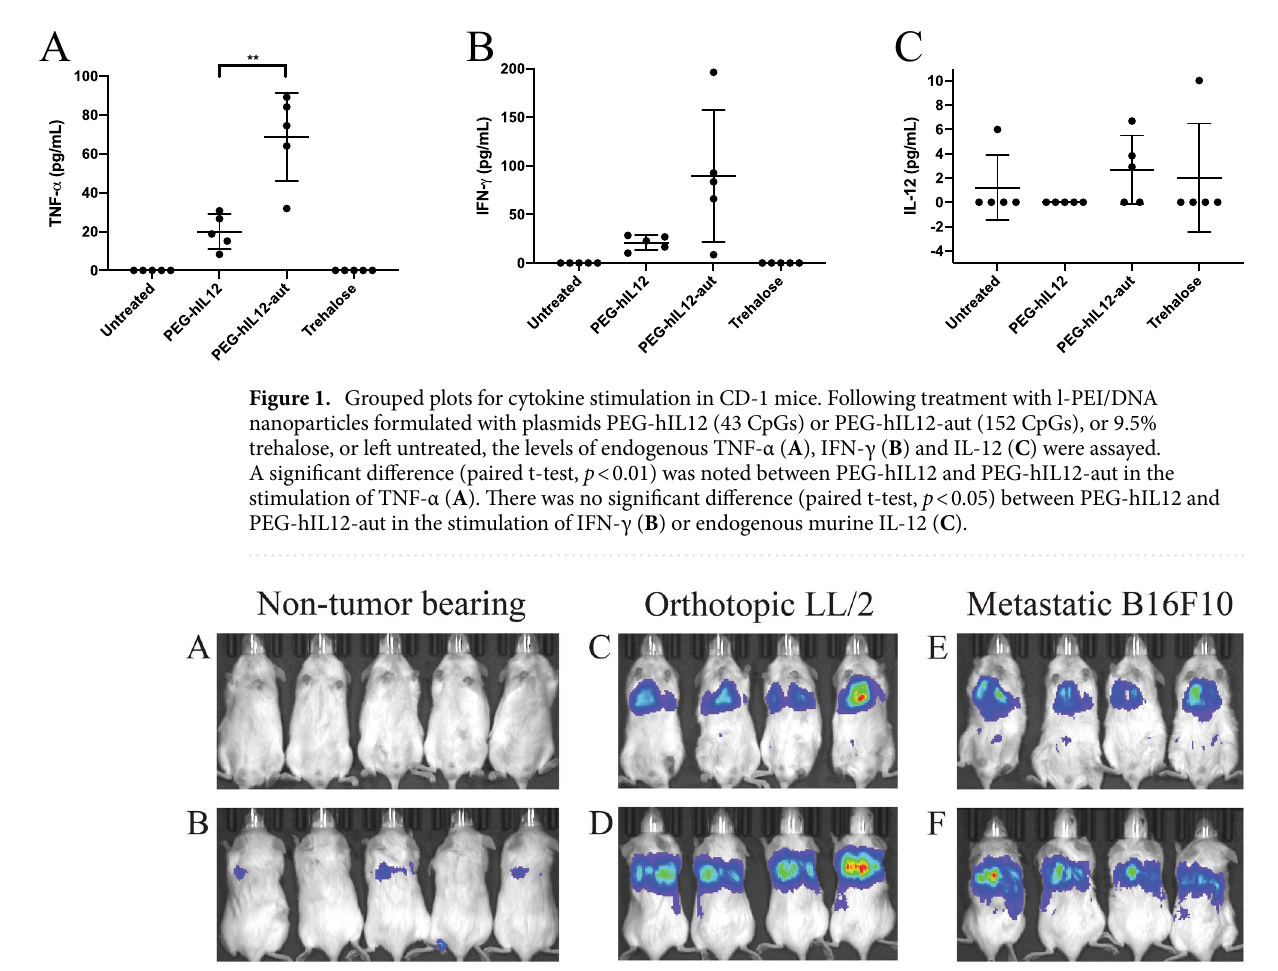
Figure 2. Bioluminescence images of NSG mice (LL/2 or B16F10) intravenously injected with PEG-fluc FNC particle. At 7 d post injection of the LL/2 tumor cells or 14 d post injection of B16F10 tumor cells, mice were injected with reconstituted FNC particles expressing firefly luciferase. Mice were imaged 48 h post injection of the particles with IVIS Spectrum In Vivo Imaging System. Ventral ( A , C , E ) and dorsal ( B , D , F ) views of the same mice are shown for the non-tumor bearing mice ( A , B ), LL/2 ( C , D ), and B16F19 ( E , F )